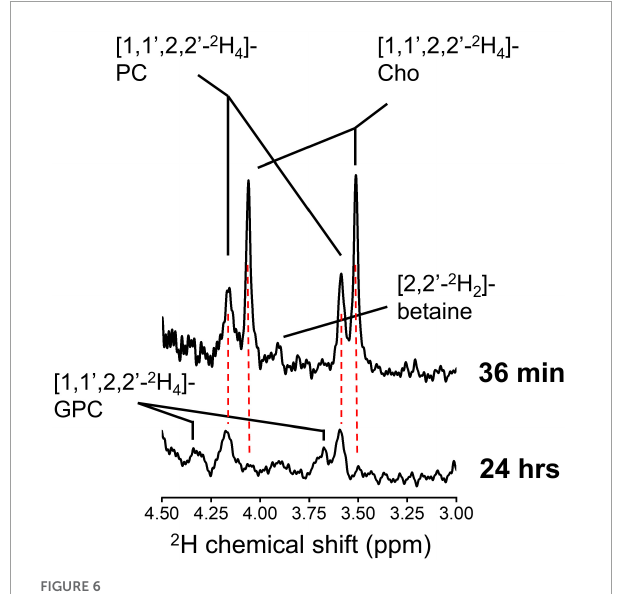
FIGURE6 High resolution 2 H NMR. 2 H NMR spectra from tumor tissue metabolite extract collected from an animal euthanized immediately after 36 min infusion of 2 H 9 -Cho (top) , and from an animal euthanized 24 h after the infusion (bottom) . Cho, choline; PC, phosphocholine; GPC,